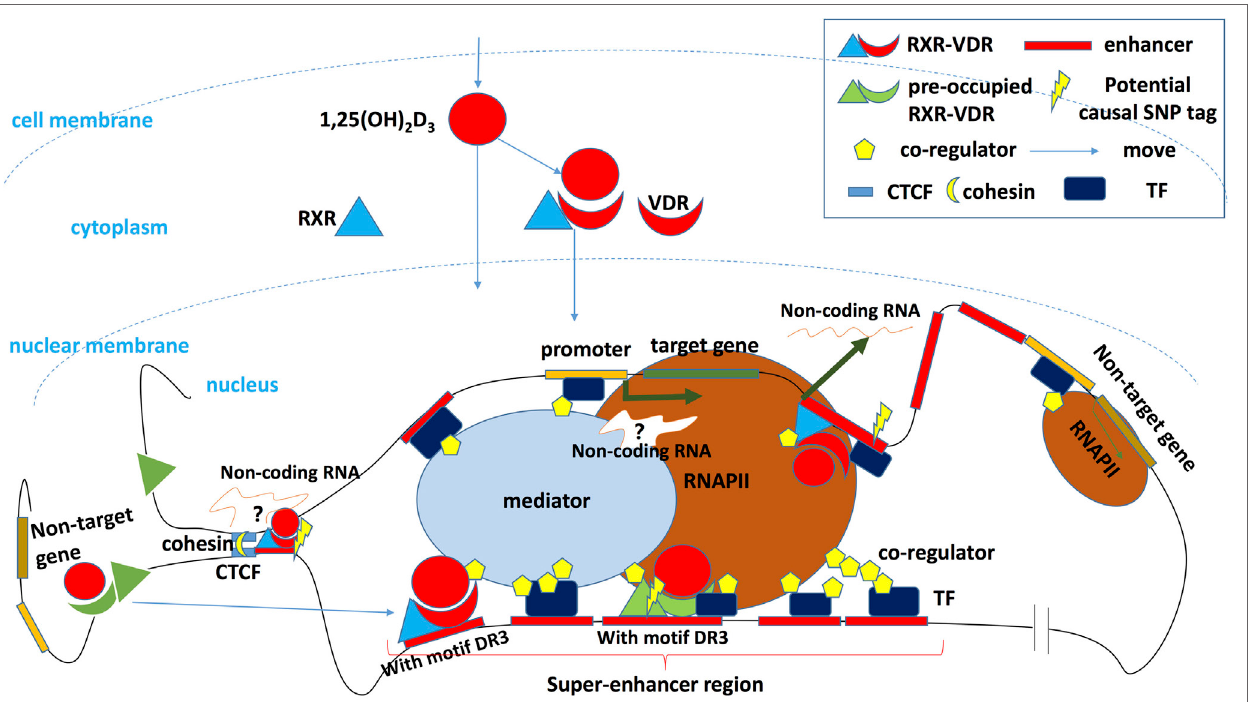
FiGURe 1 | Vitamin D regulates the transcription of target genes. After binding its ligand 1,25(OH) 2 D 3 and recruiting its partner retinoid X receptor (RXR), vitamin D receptor (VDR) enters the nucleus and binds to the transcription factor (TF) binding sites of target genes, where causal risk single-nucleotide polymorphism may be located. This induces transcription after the activation of other components of the transcription complex has been completed. A key enhancer can potentially be transcribed into a non-coding enhancer RNA, which regulates gene transcription or orchestrates cohesion-dependent looping to bring target gene promoter and enhancer region into a single-loop domain. The transcription activity of the whole domain is limited and regulated in a 3D loop isolated from other DNA regions by CCCTC-binding factor (CTCF) and cohesin (148), and some of CTCF overlap with binding of VDR (125, 126). Enhancers bound by VDR/RXR especially that in the so-called super-enhancers (SEs) or TF hotspot regions will recruit coregulators that shape chromosome landscapes and cooperate with other TFs. Other genes that are located in the 3D loop but outside the regulatory hub can also be transcribed but at lower rate. Outside the 3D loop, preoccupied VDR or RXR can be detected without vitamin D stimulation showing only low regulatory activity. Some preoccupied basal RXR binding sites can predict VDR binding sites following 1,25(OH) 2 D 3 stimulation and could represent storage regions for the VDR in the absence of 1,25(OH) 2 D 3 . After ligand binding, these “stored” VDR can shift to a DR3 motif in intronic and intergenic regions of regulated genes (120). However, the preoccupied VDR region with DR3 motif plays a master (persistent/mother) enhancer role, persist, and will promote the whole region activation and SE shaping. Secondary VDR binding region without DR3 motif (suggesting it binds DNA via interaction with other pioneer TFs or via non-classic unknown RXR/VDR motifs) will constitute subservient (secondary/daughter) enhancers around master enhancers in SE region (121,